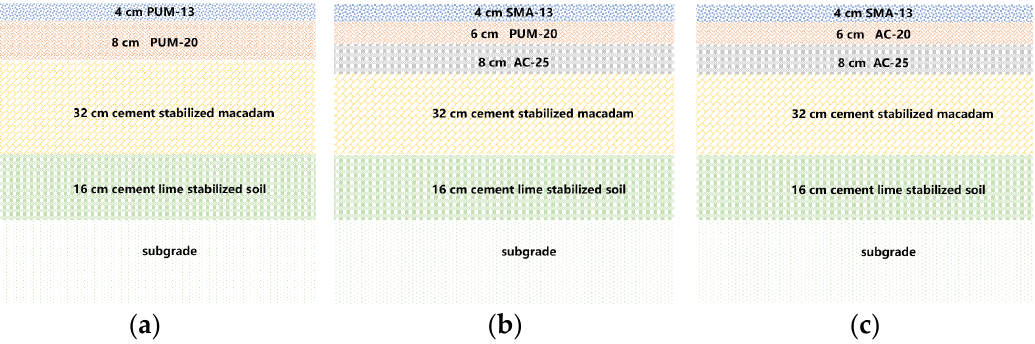
Figure 3. Typical PU pavement and asphalt pavement structure. ( a ) Double layer PU mixture pavement. ( b ) Polyurethane–asphalt composite pavement structure. ( c ) Typical asphalt pavement.